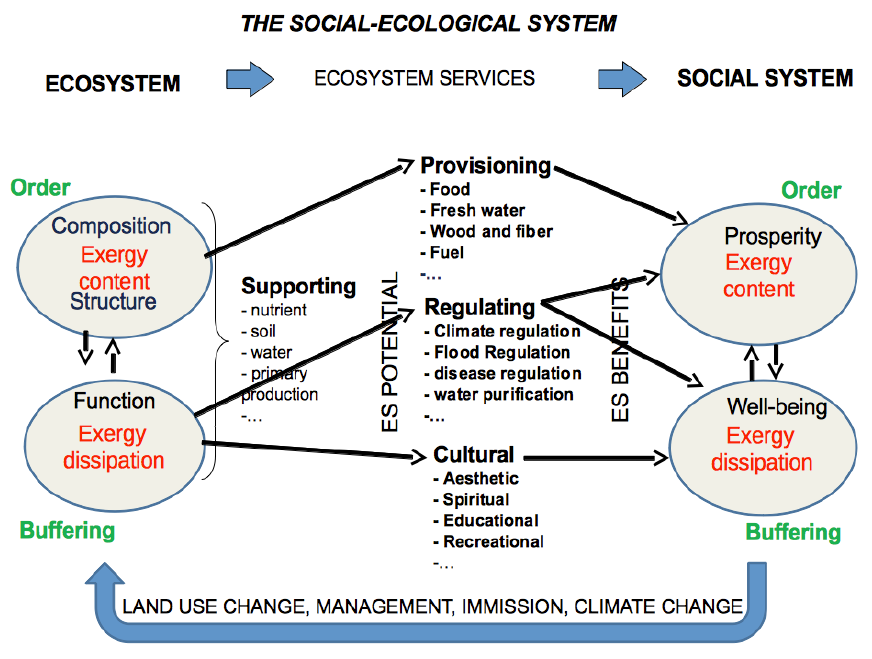
Figure 3. Conceptual scheme showing the relationships between ecosystems and social systems as closely interlinked subsystems of the overarching social-ecological systems occurring in the biosphere. Both subsystems develop a structural/compositional component (exergy content), which provides exergy to their functional component (buffering). The composition, structure and function of the ecosystem offer a potential source of ecosystem services to human society [39,40], which may use the ecosystem service benefits to increase prosperity (the economic pillar of development) and well-being (the social pillar of development). The feedback arrow at the bottom illustrates that ecoystems are heavily shaped by deliberate and unintended human influences.